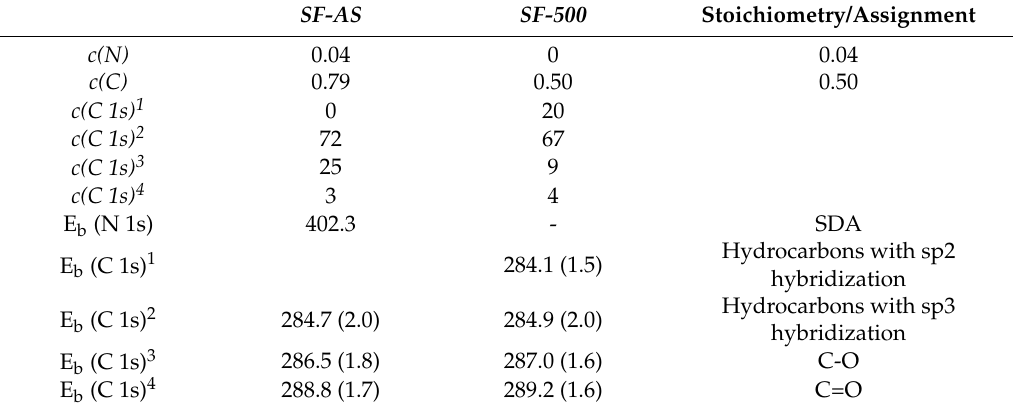
Table 2. Concentrations of c(N) and c(C) , binding energies E b , and full widths at half maximum (FWHM, in brackets) of photoelectron lines (eV) obtained by simulation of photoelectron spectra.